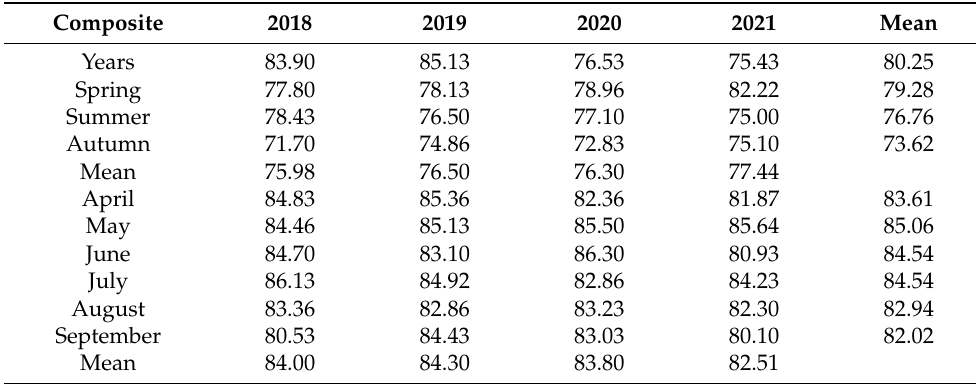
Table 2. Overall accuracy of years, seasons and monthly